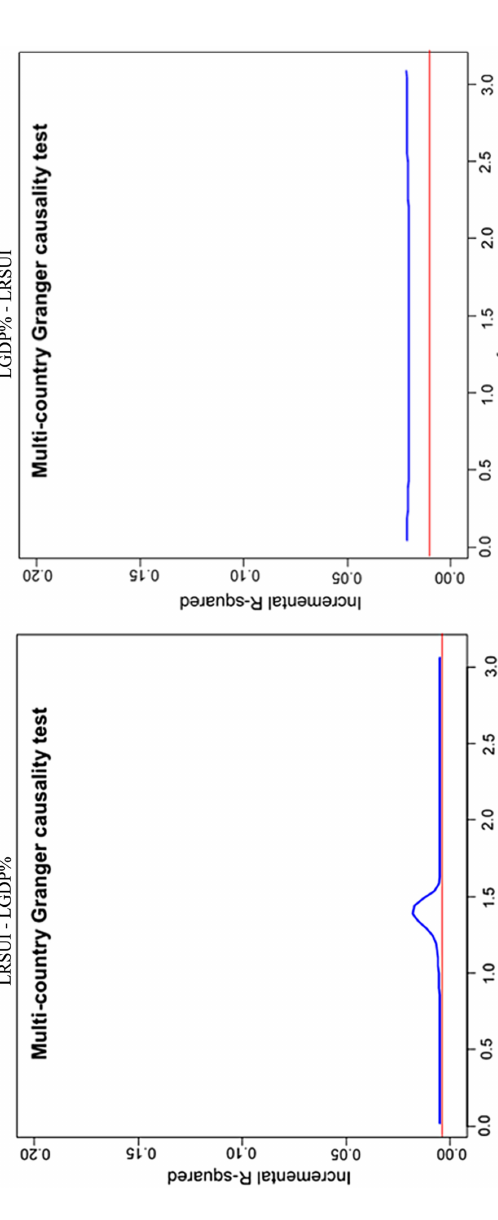
Figure 2. Graphical representation of panel frequency causality